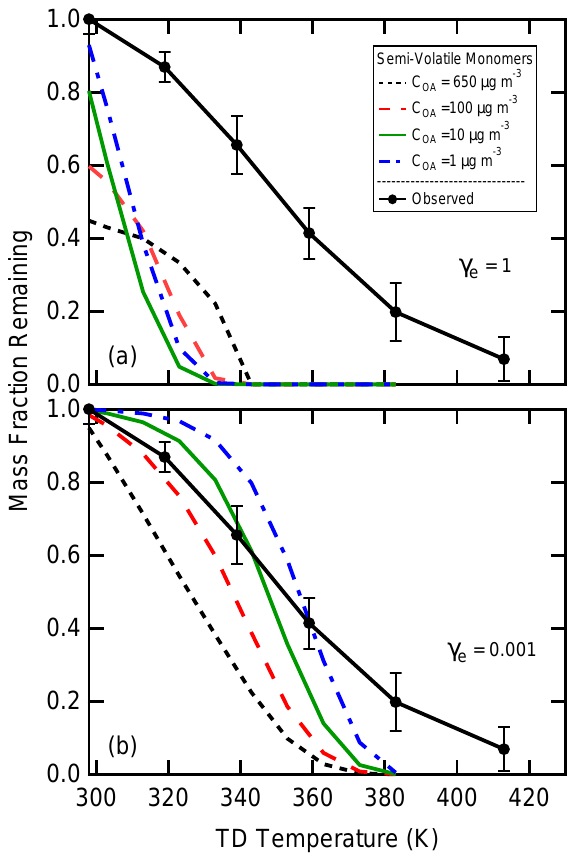
Figure 3. Model predictions for the mass thermograms of α - pinene + O 3 SOA using the semi-volatile monomer TD model where the initial model C OA was 650µgm − 3 (black, short dash), 100µgm − 3 (red, long dash), 10µgm − 3 (green, solid) or 1µgm − 3 (blue, dot-dash) for evaporation coefficients, γ e , equal to (a) 1 and (b) 0.001. Neither set of predictions agrees well with the observed mass thermogram for medium/low C OA (black line with black •